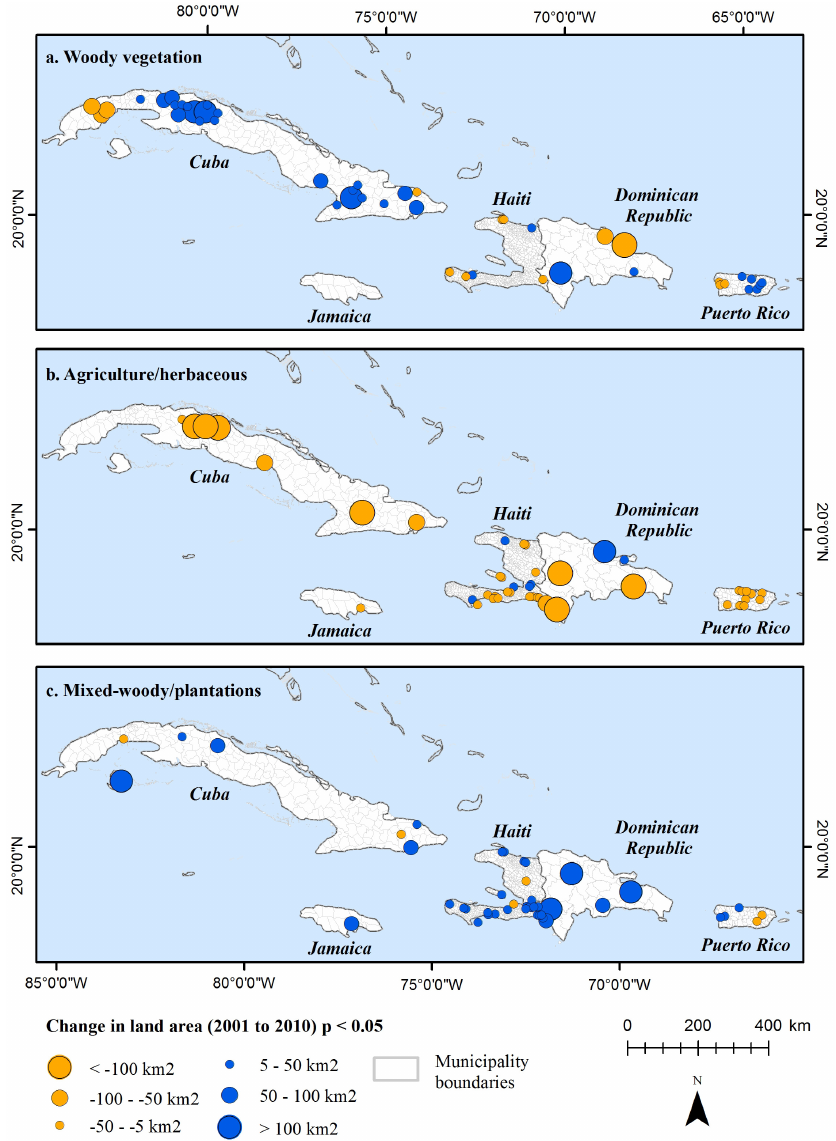
Figure 1. Gain (blue dots) and loss (orange dots) in: ( a ) woody vegetation; ( b ) agriculture/herbaceous; ( c ) mixed-woody/plantations, from 2001 to 2010 in km 2 . Only municipalities with a significant ( p ≤ 0.05) 10-year trend and more than 5 km 2 of change are highlighted.